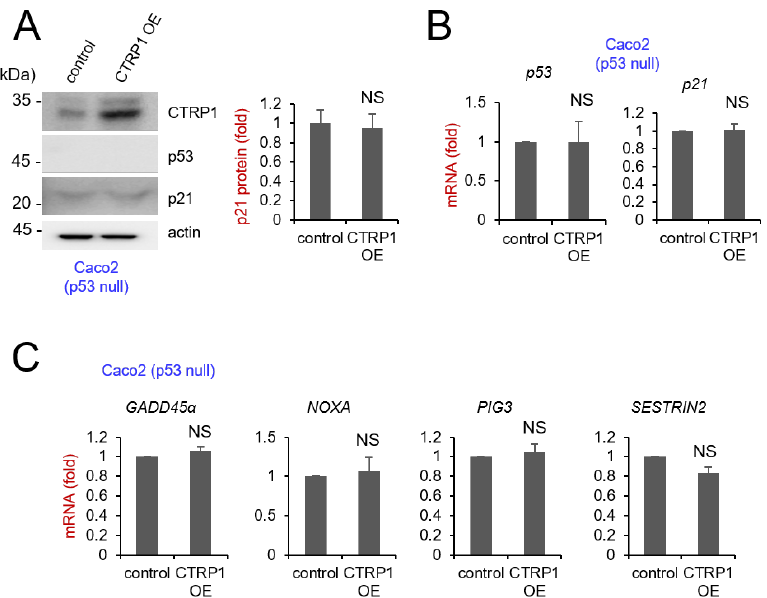
Figure 3. CTRP1 overexpression in Caco2, a p53 null cell line did not decrease p53 and p53-depend- ent transcription. ( A ) CTRP1 OE Caco2 cells did not show a decrease in p21 protein level. Caco2 cells were infected with either control lentivirus or CTRP1 encoding lentivirus. Seventy-two h after CTRP1 lentivirus infection, cells were harvested, and equal amounts of cell lysates were probed with the indicated antibodies (left panel), and the level of p21 protein was quantified and depicted in the graph (right panel). Images of the uncropped western blots can be found in Figure S3. ( B ) CTRP1 OE Caco2 cells did not decrease p53 and p21 mRNA level. The expression levels of p53 and p21 mRNAs were measured using quantitative RT-PCR. Control vs. CTRP1 OE in Caco2 cells. NS: Not Significant. ( C ) CTRP1 OE Caco2 cells did not decrease the mRNA level of p53-dependent tran- scription. The expression levels of GADD45α, NOXA, PIG3, and SESN2 mRNAs were measured using quantitative RT-PCR. NS: Not Significant.